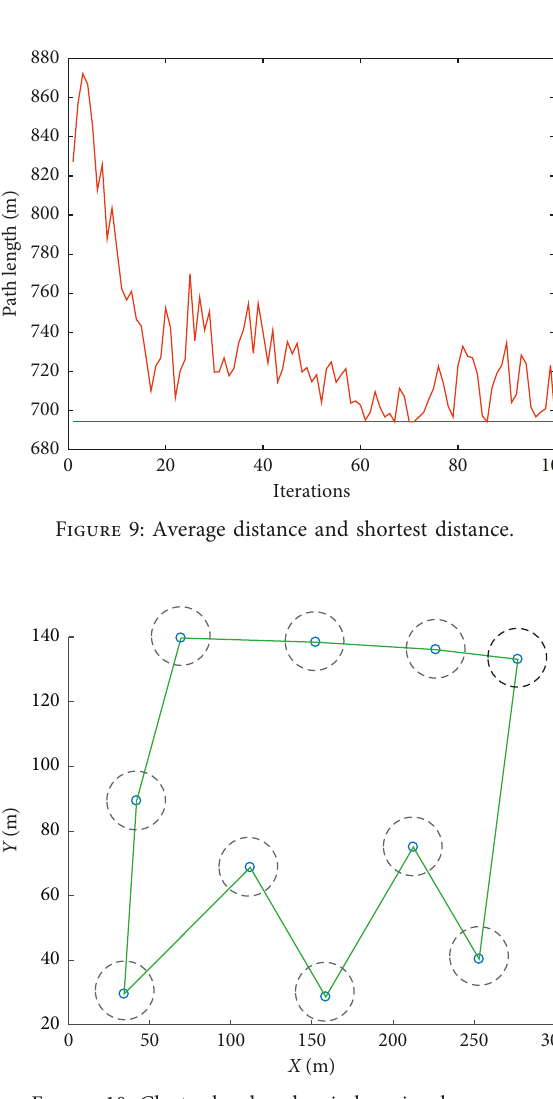
Figure 10: Cluster head node wireless signal